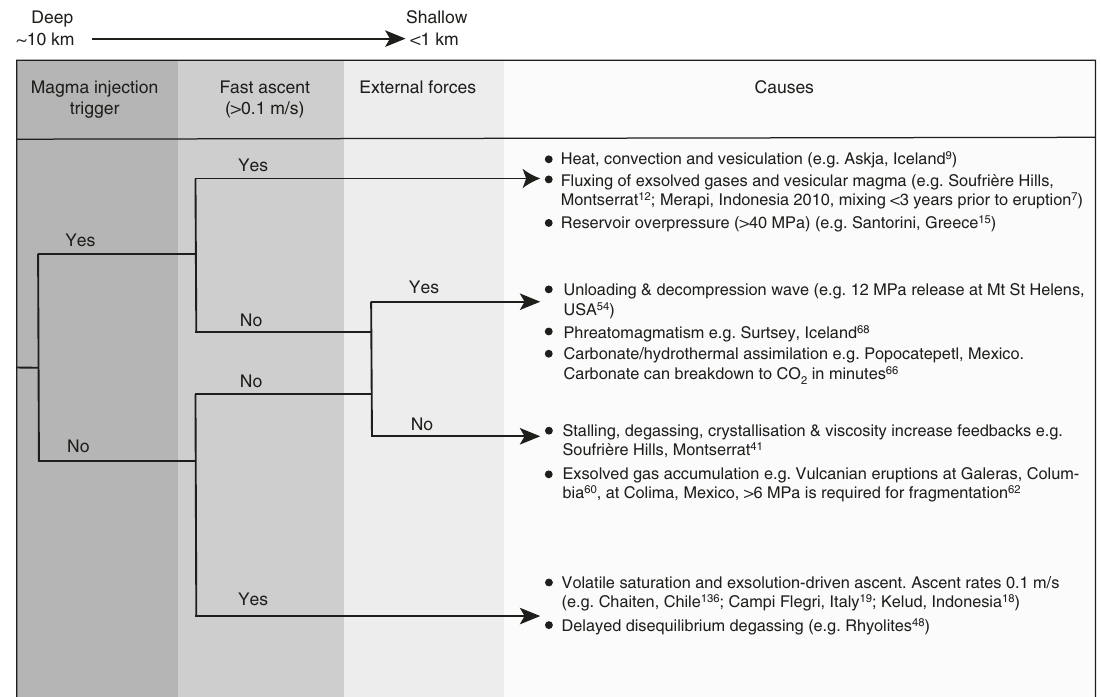
Fig. 4 Event tree diagram showing the different processes/conditions that may lead to explosive eruptions. Slow ascent scenarios often involve transitions between explosive and effusive activity. Speed of ascent may fl uctuate during an eruptive phase, this diagram refers to the average ascent rate from storage to the